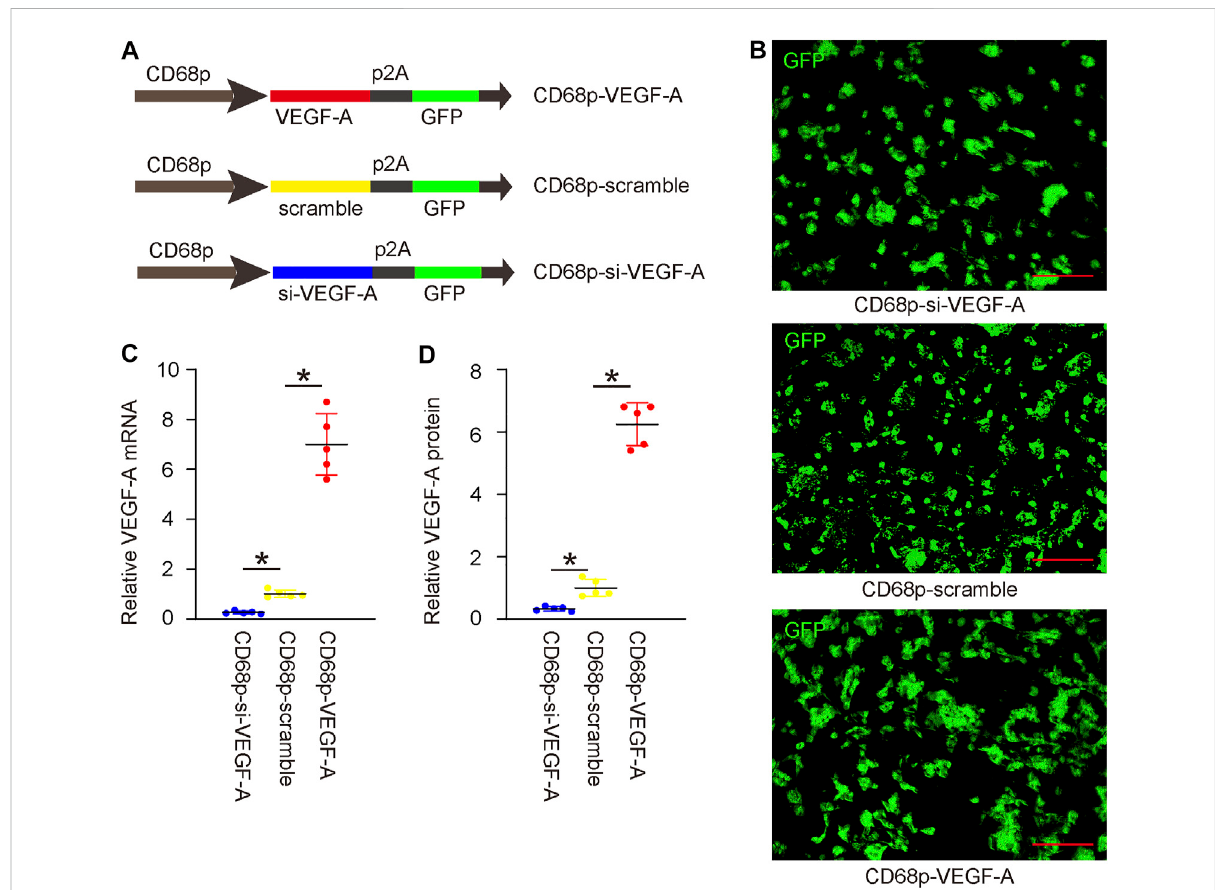
FIGURE 4 Generation and validation of AAVs with altered levels of VEGF-A. (A) AAVs carrying either complete coding sequence for VEGF-A or siRNA for VEGF-A (si-VEGF-A) under a macrophage-speci fi c CD68 promoter were prepared. A scramble sequence was used to replace the transgene to be driven by the CD68 promoter as well. All 3 AAVs contained a GFP reporter to be co-driven under the CD68 promoter using a p2A construct. (B) IL-4 primed bone marrow derived macrophages (BMDM) were transduced with 3 AAVs. GFP was shown in cultured cells. (C) RT-qPCR on VEGF-A mRNA. (D) ELISA on VEGF-A protein. * p < 0.05. N = 5. Scale bars were 100